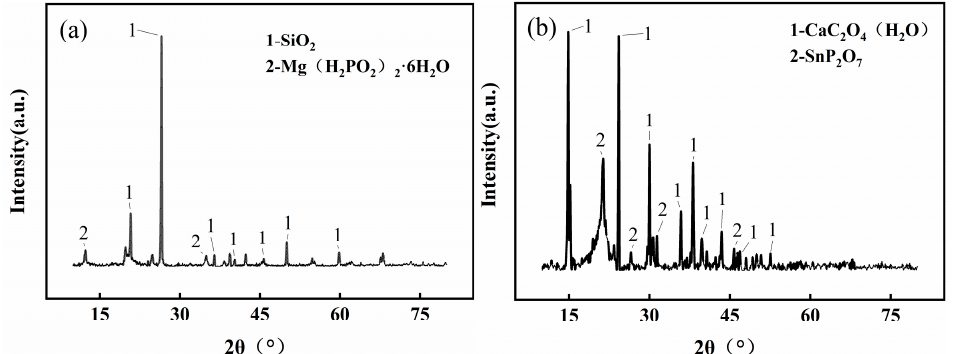
Figure 1. X-ray diffraction analysis pattern: ( a ) lignite; ( b ) poplar leaves.